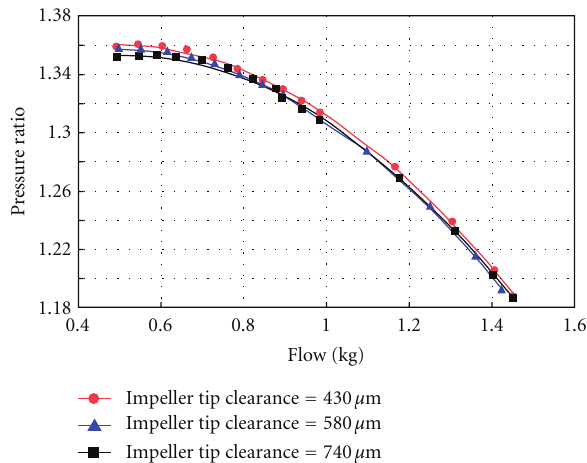
Figure 17: Impeller tip clearance modulation at 16,287 rpm.